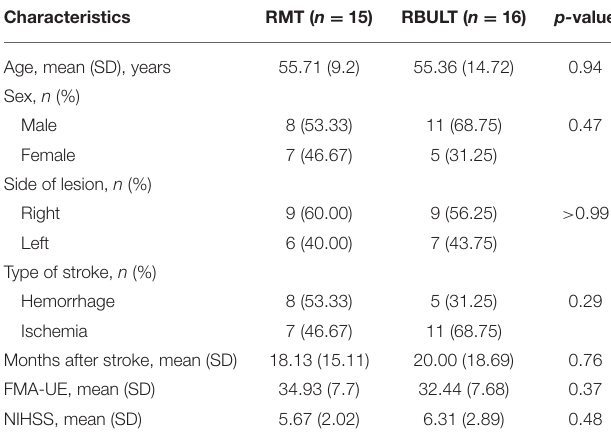
TABLE 1 | Demographics and baseline clinical